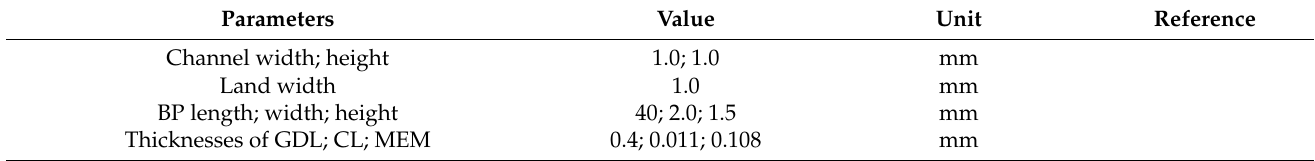
Figure 2. Schematic of ordered proton exchange membrane fuel-cell model. Table 2. Physicochemical properties and operation conditions of